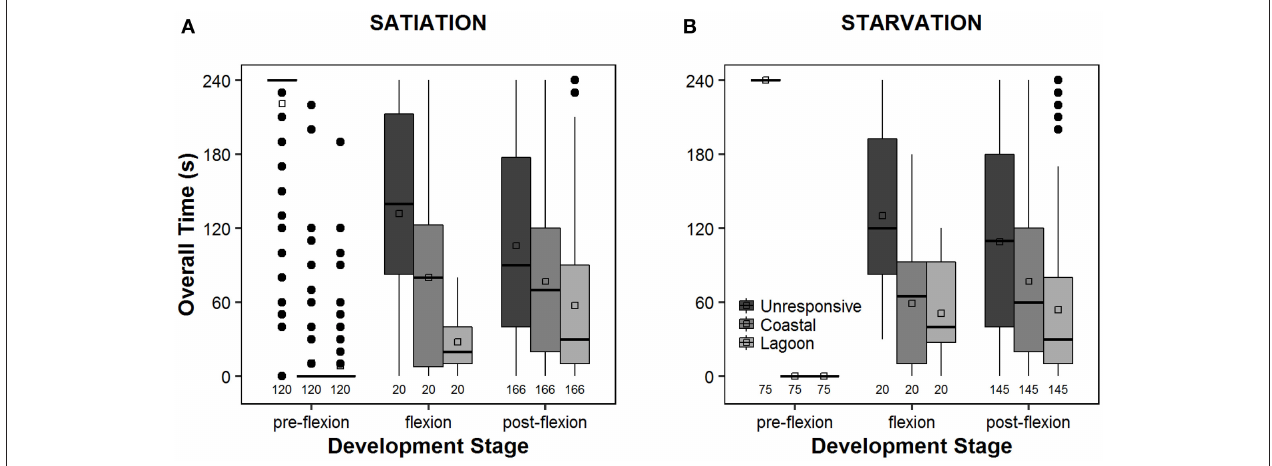
FIGURE 5 | Box-n-whiskers plots representing the non-consecutive overall time (seconds) that Sparus aurata larvae spent exhibiting a given behavior (unresponsive, or preference for coastal or lagoon water), during choice-chamber trials, performed along ontogeny (pre-flexion, flexion, post-flexion) and in satiation (A) and starvation (B) conditions. The behavior of each larva was assigned after two choice-chamber trials, and those larvae with inconclusive behavior were not considered in these analyses. The plot depicts the 1st and 3rd quartiles, median, mean and outliers, as well as the 5th and 95th percentiles as the minimum and maximum whiskers, respectively. Legend: open squares represent the mean; thick black line represents the median; full black circles represent the outliers; the numbers at the bottom of the graph account for the number of observations made.